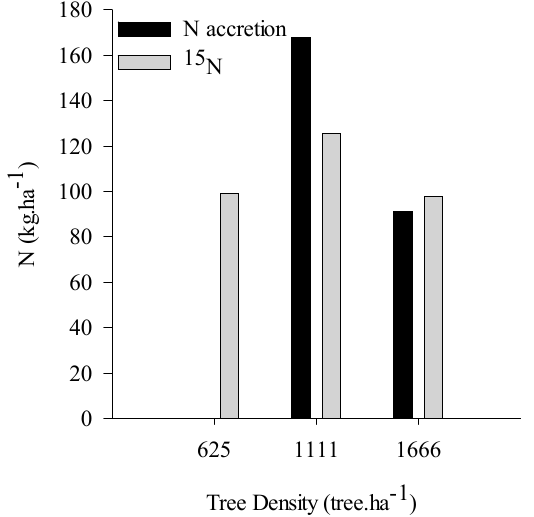
Figure 3. N fixed (kg ha − 1 ) by A. peregrina in three stand densities estimated by the N accretion (black columns) and by 15 N natural abundance (grey columns) methods.